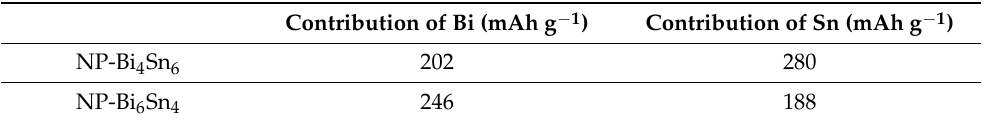
Table 4. Performances of Mg cells assembled with NP-Bi 4 Sn 6 and NP-Bi 6 Sn 4 anodes, with a focus on the contribution of each